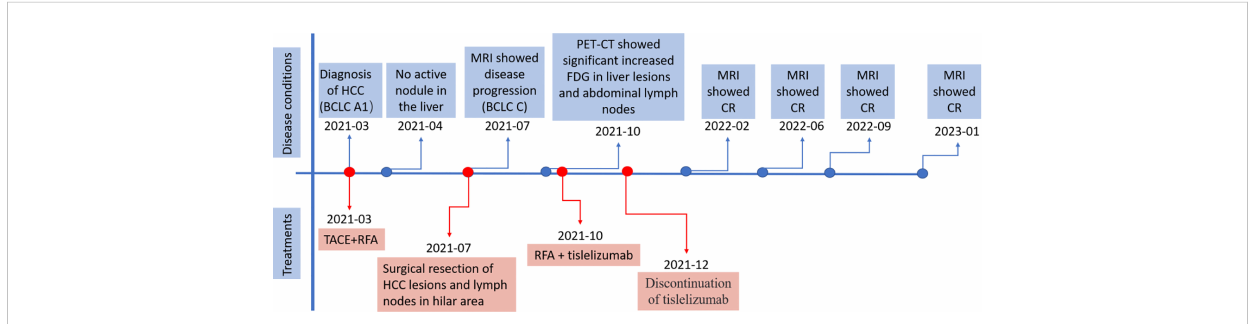
FIGURE 5 The treatment timeline. HCC, hepatocellular carcinoma; BCLC, Barcelona Clinic Liver Cancer. TACE, transcatheter arterial chemoembolization; RFA, radiofrequency ablation; MRI, magnetic resonance imaging; PET-CT, positron emission tomography-computer tomography; FDG, fl uorodeoxyglucose; CR, complete